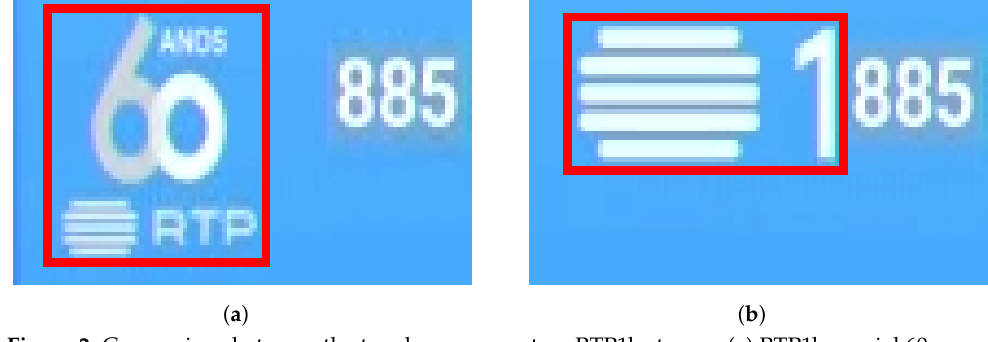
Figure 2. Comparison between the two logos present on RTP1b stream. ( a ) RTP1b special 60 years logo. ( b ) General RTP1b logo in the immediate next frame.